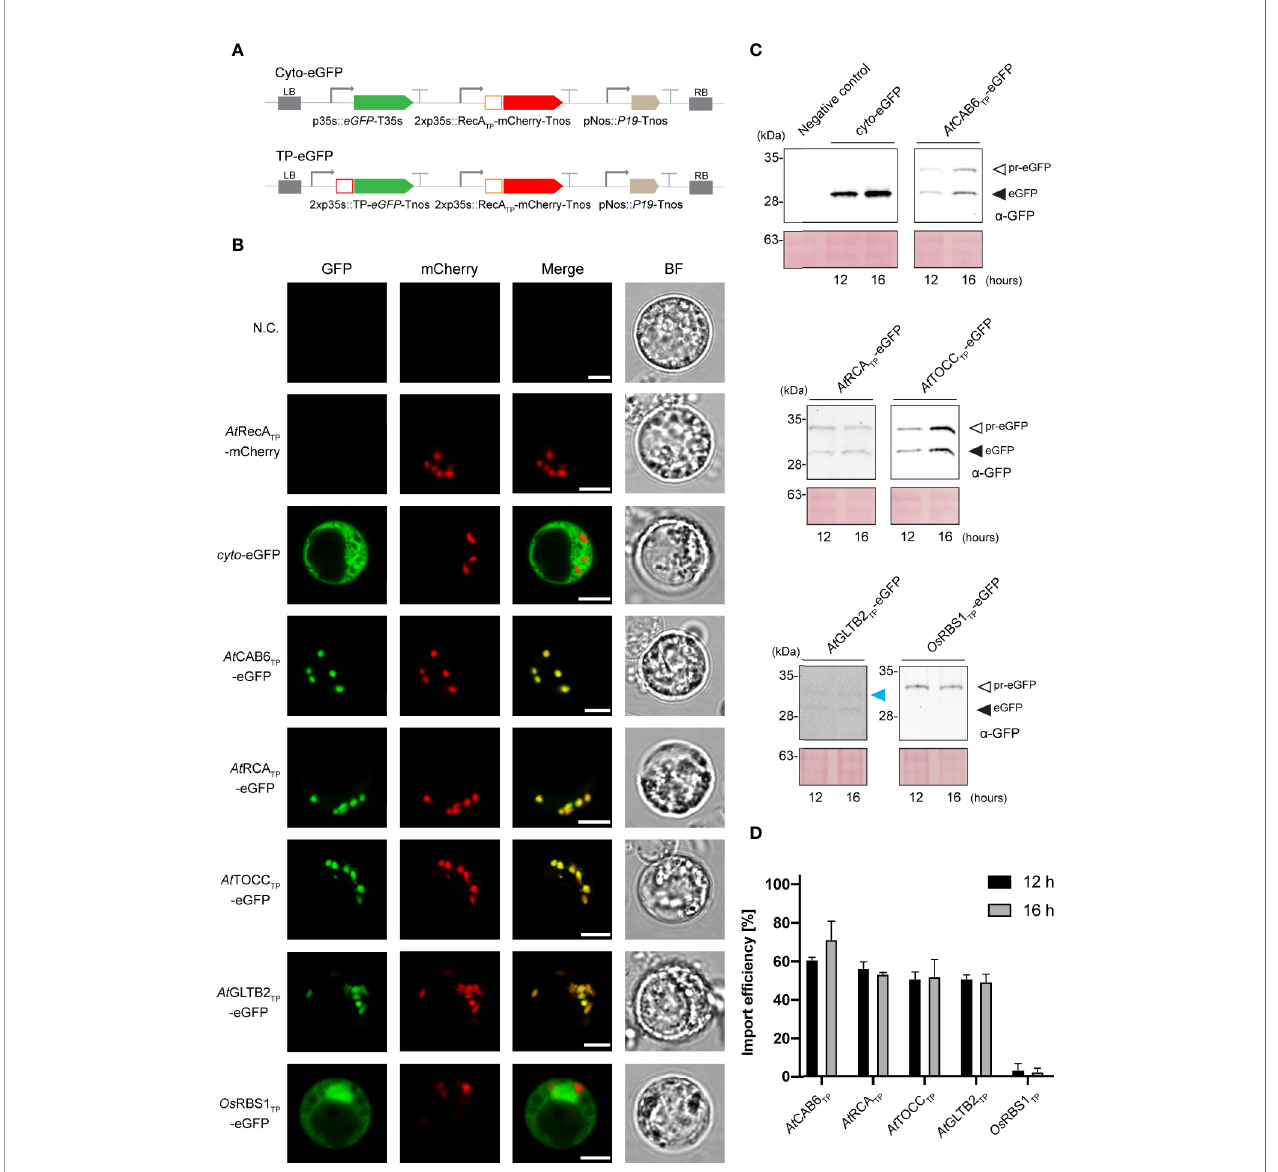
FIGURE 2 | In vivo leucoplast targeting of TP-eGFP fusion proteins in Arabidopsis root protoplasts. (A) Schematic representation of the constructs used in A. thaliana transient expression assays leading to eGFP expression and localization. (B) Confocal laser scanning microscopy images of A. thaliana root protoplast expressing indicated TP-eGFP fusions. N.C. corresponds to “ Negative Control ” , nontransformed protoplasts. The four columns show individual signals for eGFP (green, on the far left), mCherry (red, on the left) and transmitted light (BF, on the far right). On the right, overlap of eGFP and mCherry signals (merge). Scale bars = 5 µm. (C) Western-blot analysis of import experiments. Protoplast isolated from A. thaliana roots were transformed with indicated TP-eGFP fusions and total protein extracts were analyzed by Western blotting using anti-GFP antibody. The experiments were performed in three biological replicates and representative data is shown. White arrows (pr-eGFP) indicate precursor form; black arrows (eGFP) indicate, processed form; blue arrow indicates partially processed form. (D) Quanti fi cation of import ef fi ciency of TPs into Arabidopsis root plastids. Import ef fi ciency was de fi ned as the percentage of the processed faster-migrating protein form relative to the total amount of expressed eGFP protein in each line. Data represent means (n = 3) with SD, except GLTB2 and RBS1 TPs, where